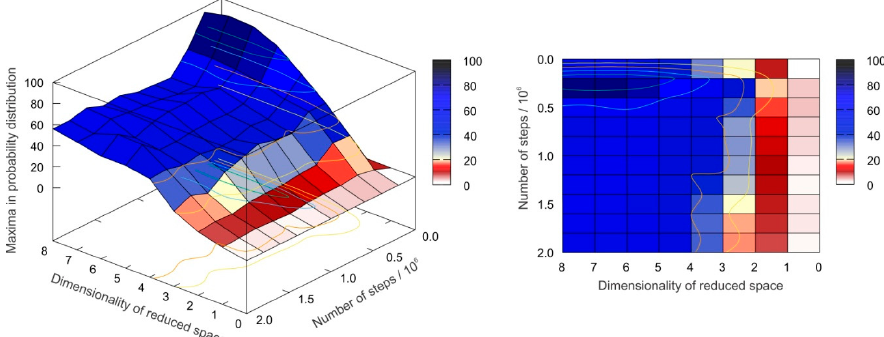
Figure 6. Total number of strict local maxima in the probability distribution for geometries of compound 2 in the reduced space calculated by the principal component analysis of the molecular dynamics trajectory.